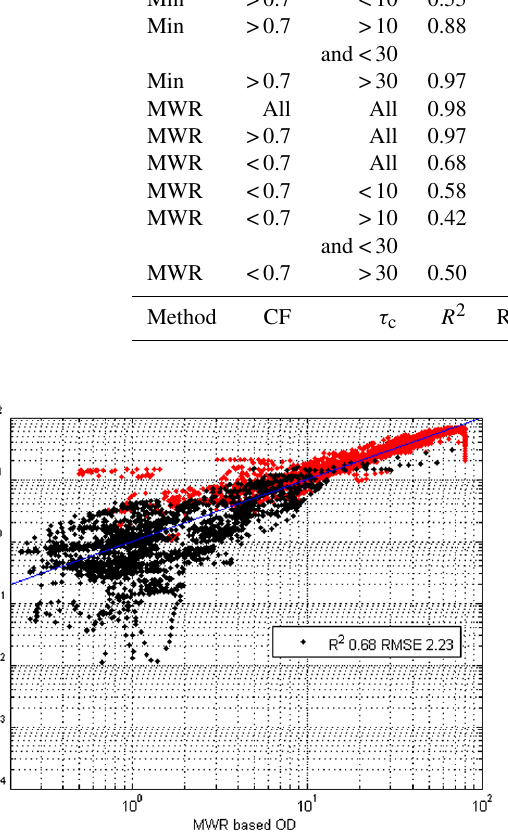
Figure 16. Comparison of USI RRBR vs. MWR measurements of cloud optical depth for CF<0.7 in black and CF>0.7 in